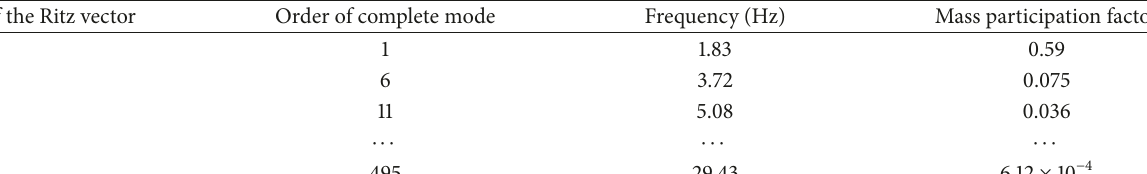
Table 2: Characteristic parameters of the soil.